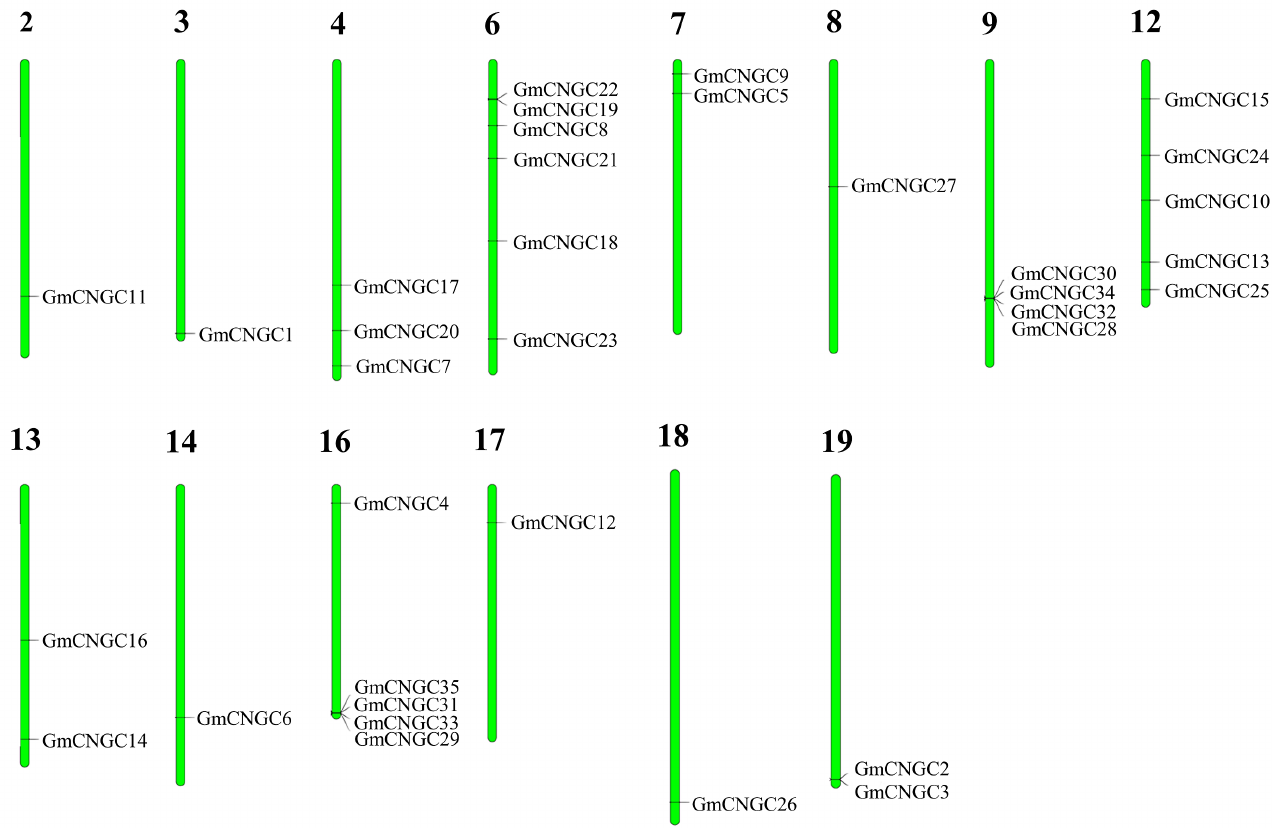
F igure 2. Locations of CNGC genes on G. max chromosomes. Figure 2. Locations of CNGC genes on G. max